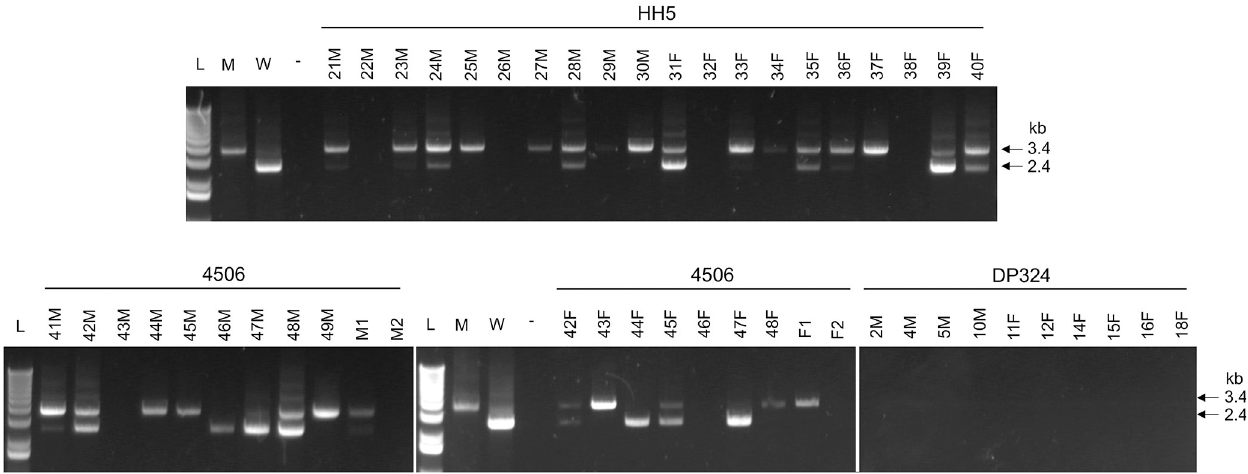
Fig 7. The presence of wild-type and mutant A . marginale in ticks assessed following blood feeding on MLAV group animals and their subsequent molting. Genomic DNAs from 20 ticks fed on each animal (10 males and 10 females) from steers 4506 and HH5 were tested for the presence of wild-type and phtcp mutant A . marginale by conventional PCR targeting to amplify the entire insertion-specific region; anticipated product size for wild-type and mutant are 2.4 kb and 3.4 kb, respectively. As a total of 60 randomly selected ticks (30 males and 30 females) fed on animal # DP324 were negative for both wild-type and mutant A . marginale by qPCR, 10 randomly selected ticks from this animal were also tested by conventional PCR. L, 1kb plus molecular weight markers; M, A . marginale mutant; W, Wild-type strain,—refers to no template containing negative control. The numbers with the letters M or F are to indicate the tick identification numbers and to indicate their sex; M, male and F,